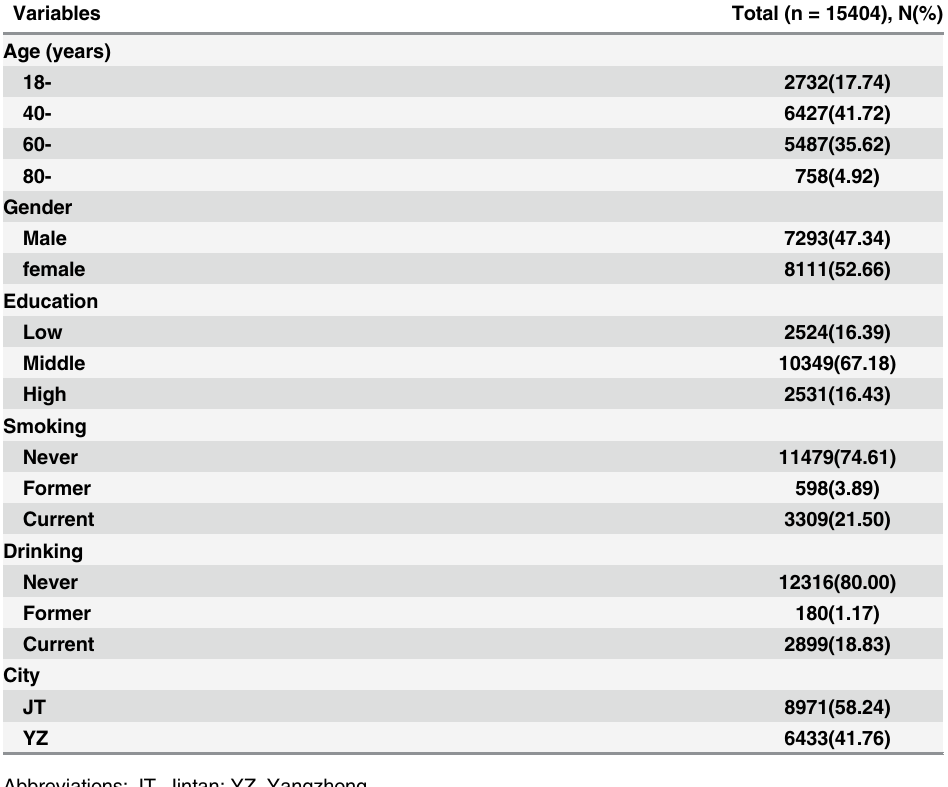
Table 1. Basic characteristics of the study